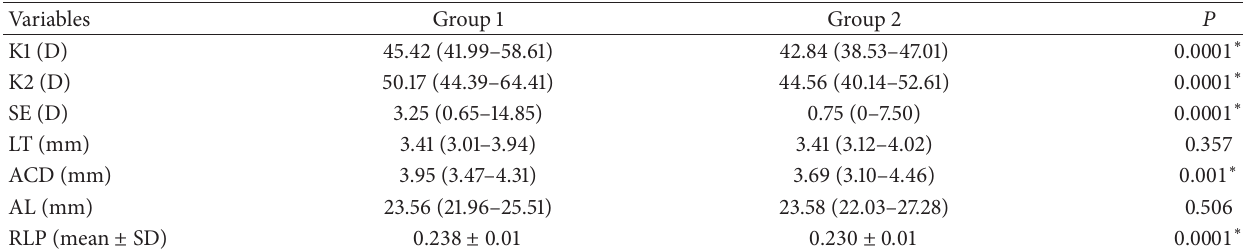
Table 4: Cycloplegic situation between groups.